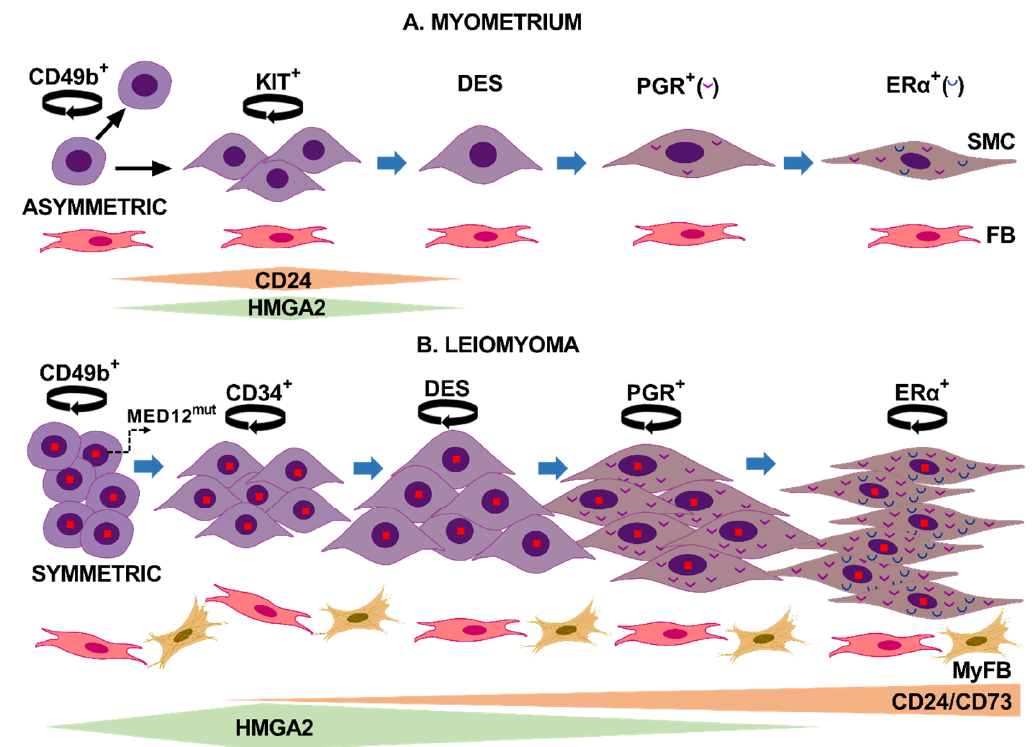
Figure 4. Proposed models illustrate cell proliferation and differentiation mechanisms in normal myometrium and uterine leiomyoma. ( A ) In normal myometrium, a CD49b stem cell asymmetrically divides (circle arrow) in two daughter cells. One cell remains a stem cell with unlimited proliferative ability, whereas the other daughter cell acquires the KIT receptor and commits to becoming a smooth muscle cell (SMC). KIT + cells are a transit-amplifying cell population that expresses high levels of HMGA2 and CD24 during cell proliferation, and their expression levels decrease as cells begin to express desmin. In the next stage, cells acquire ovarian receptors expression, first PGR and then ER α . Communication between SMC and fibroblast (FB) may occur during the proliferation and differentiation process. ( B ) In leiomyomas, hypoxia-induced activation of MED12 mutated CD49b stem cells leads to symmetrical division and stem cell expansion. These stem cells further differentiate to CD34 + /CD49b − cells expressing CD24 and probably CD73. These last two surface markers remain upregulated during the entire differentiation process to SMC. CD24 cells express increased levels of HMGA2 that remain elevated until PGR greatly increases expression. Further differentiation steps lead to the expression of desmin, then PGR, and finally ER α . Compared to normal cells, mutant leiomyoma cells express higher levels of ovarian hormone receptors. Cells maintain proliferative capacity during the differentiation process, contributing to tumor growth. Fibroblasts differentiate into myofibroblasts (MyFB), and both cell types may interact with LM cells to regulate tumor growth. This figure was created using Microsoft PowerPoint version